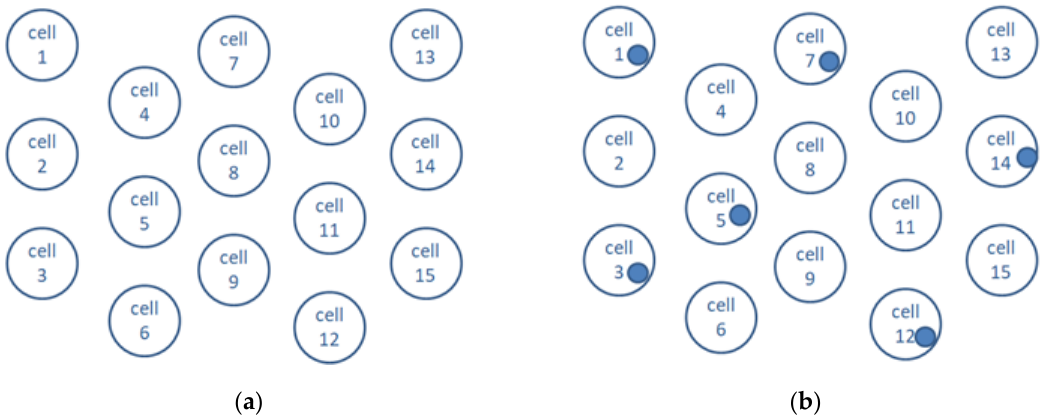
Figure 2. The example is a single life cycle of the CellS: ( a ) there are no cells triggered by the ligand; ( b ) some of the cells were triggered by the ligand.